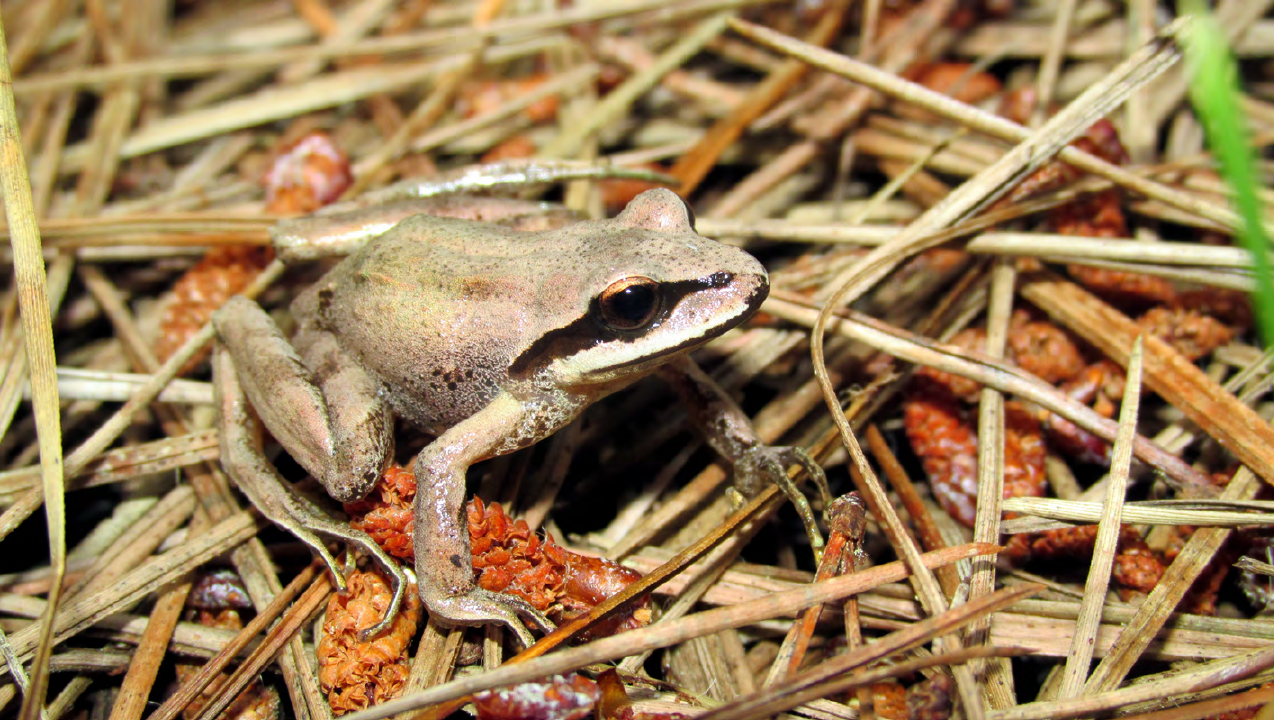
Figure 3. Individual of Batrachyla taeniata (not